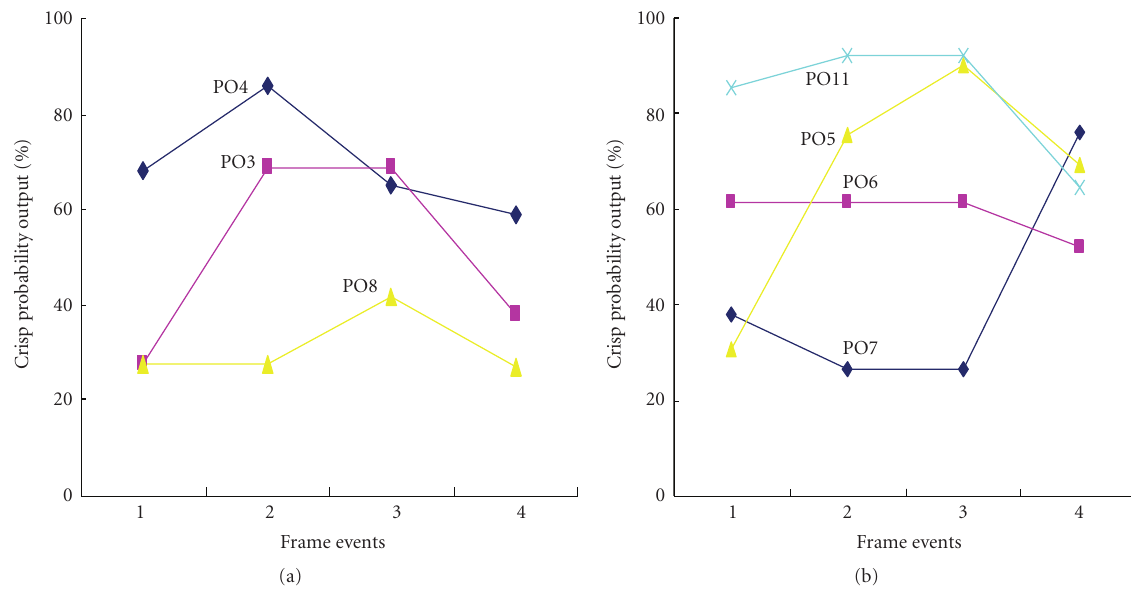
Figure 12: The graphical representation to summarize the robots behavior shown in Figure 11 with a threshold probability value of 84 %.